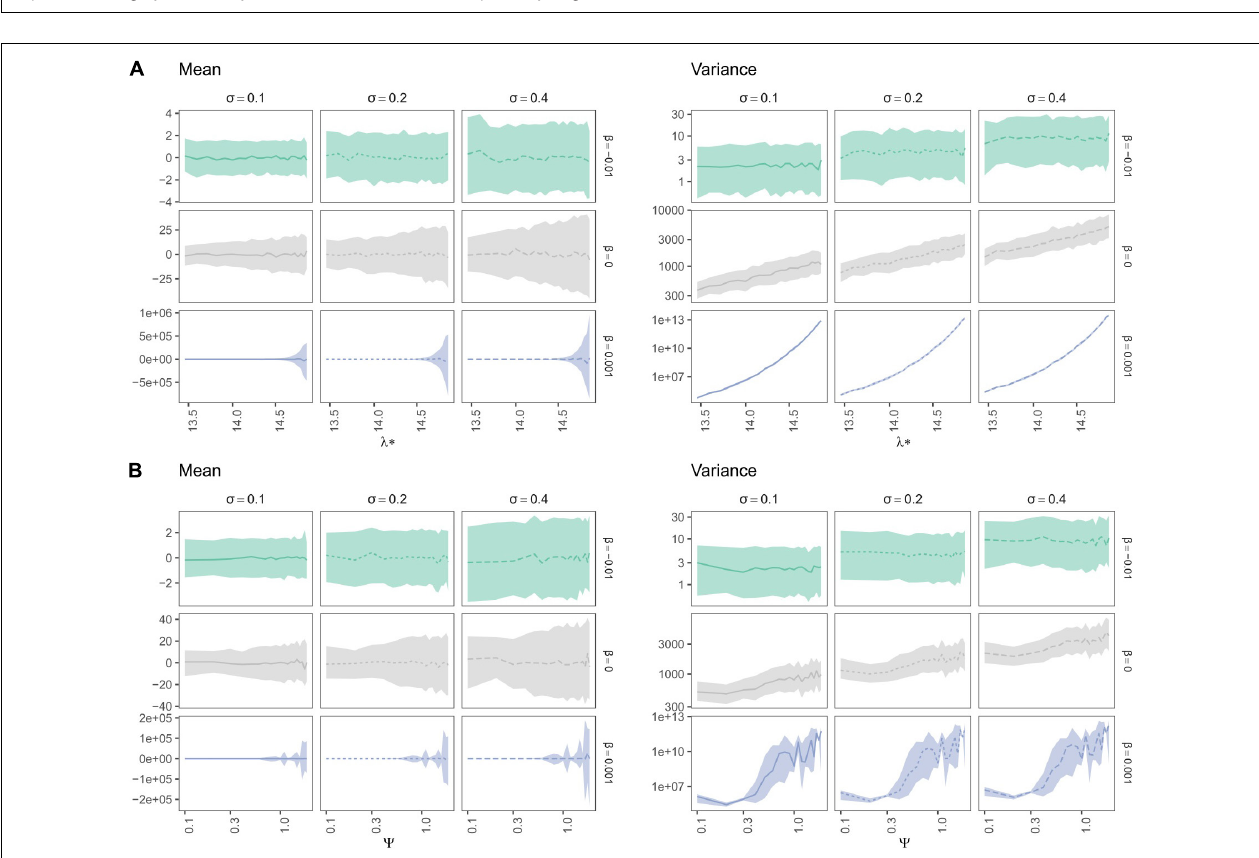
FIGURE 7 | Variation in median trait moments (mean and variance) as well as their interquartile ranges (IQR) depending on the amplitude of expansion (A). Trait mean and variance did not vary depending on the time at which expansion occurred (not shown). Species richness is fixed for all simulations ( S = 31). Brownian Motion is represented in gray, while Early and Late Burst are shown, respectively, in green or blue.